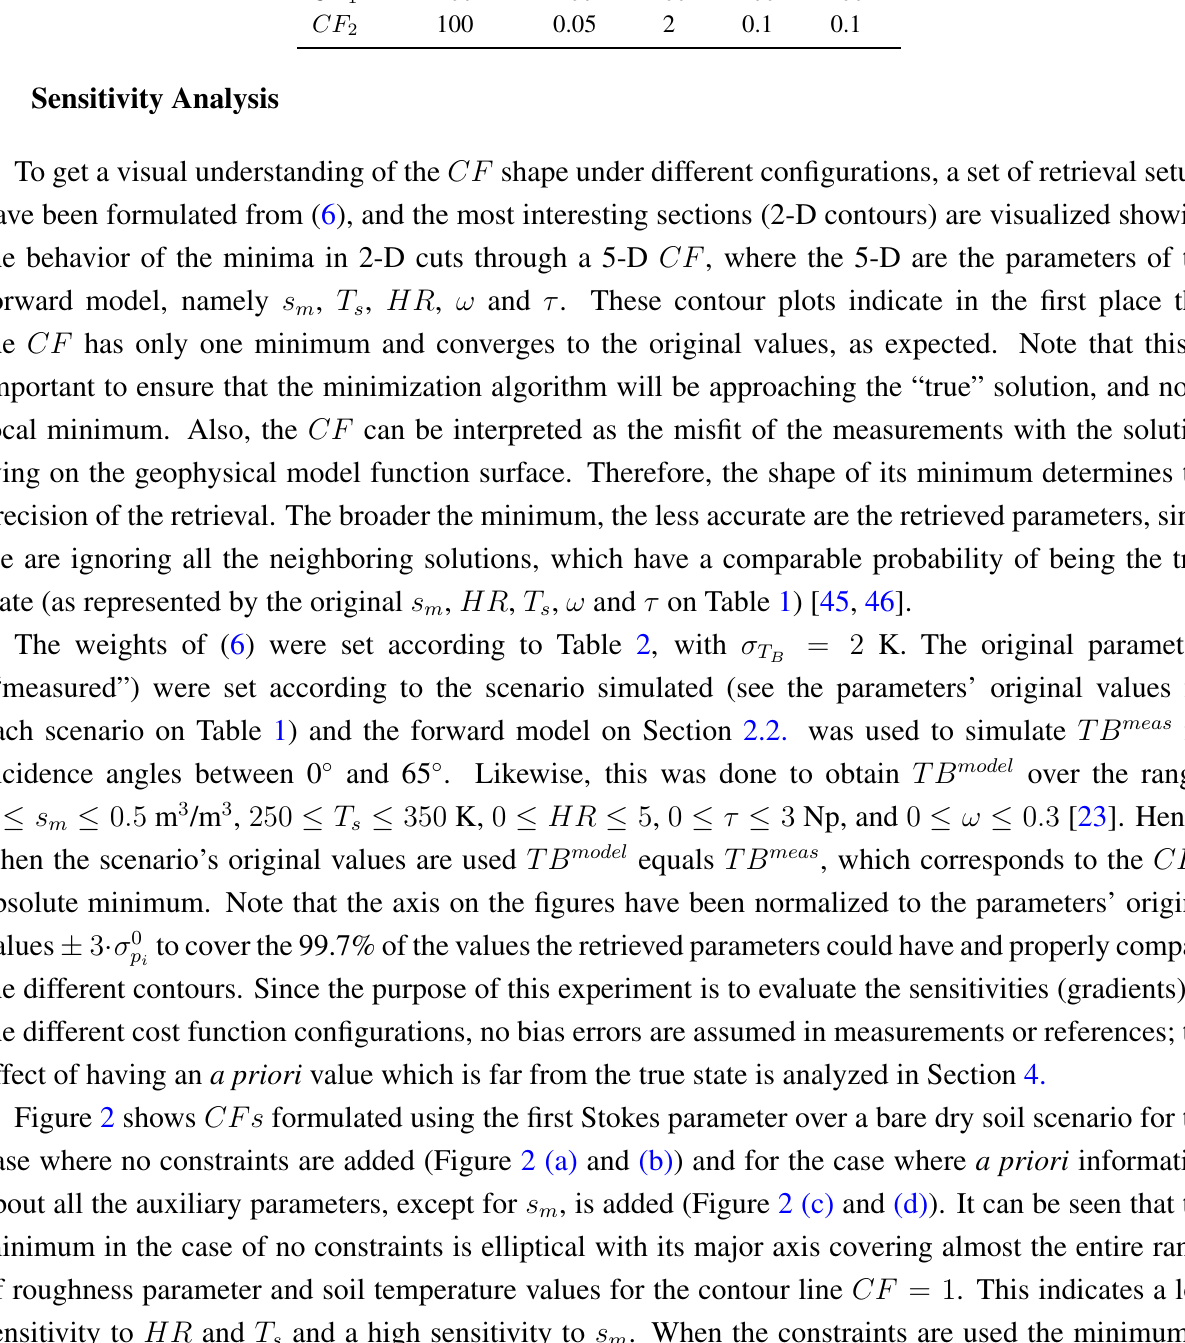
Table 2. Selected standard deviations of soil moisture ( s ( HR ), soil temperature ( T for the two selected cost function configurations CF